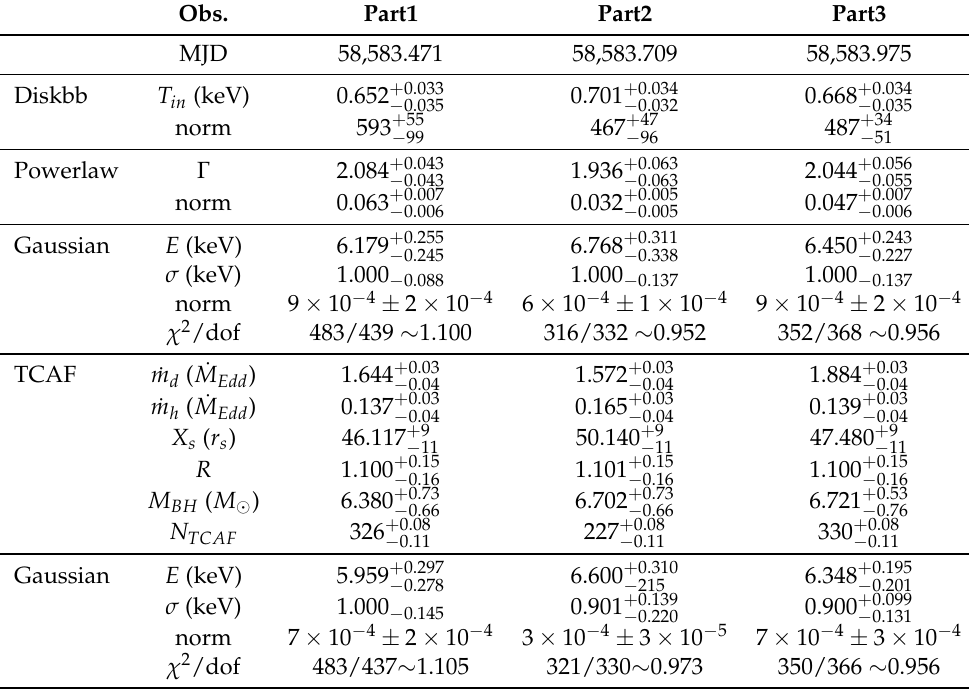
Table 2. TCAF model fitted spectral parameters for three segments of the NuSTAR observation.